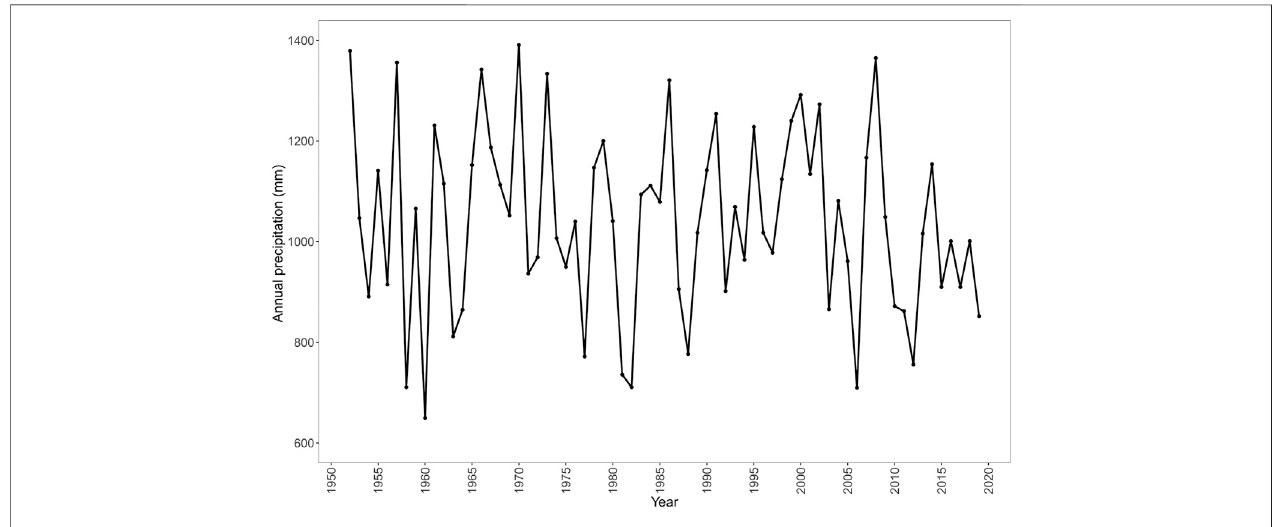
FIGURE 5 | Annual precipitation in Erhai Lake catchment from 1952 to